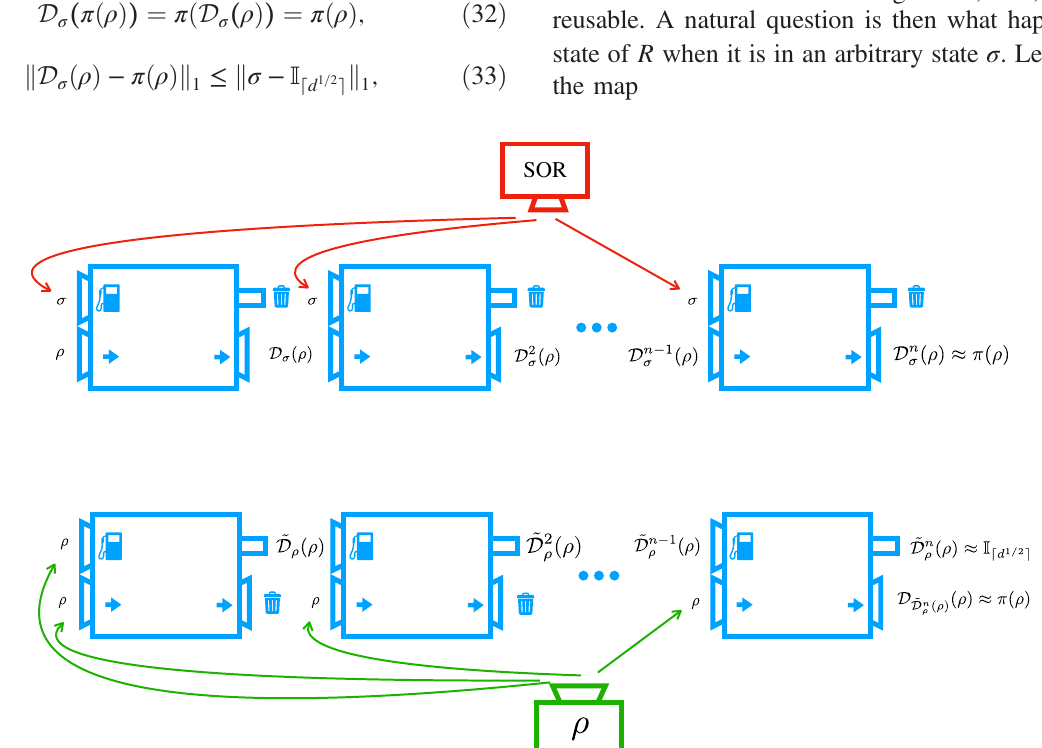
FIG. 3. Top: Repeated application on single input state approximates dephasing map. Bottom: Producing the dephased state when there is no SOR. If k ρ − I d k 1 < 1 , then the necessary amount of randomness for dephasing can be distilled by repeated application of the universal dephasing